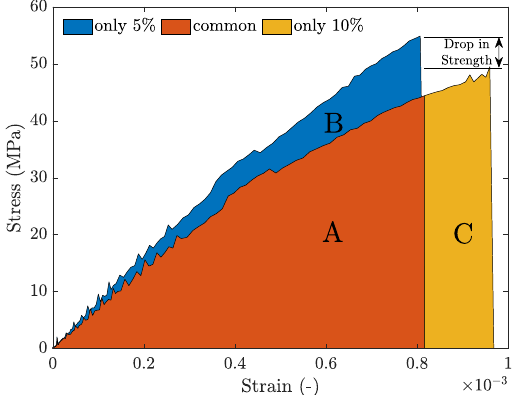
Figure 9. Trade-off between toughness and strength as the organic matrix percentage increases from 5% to